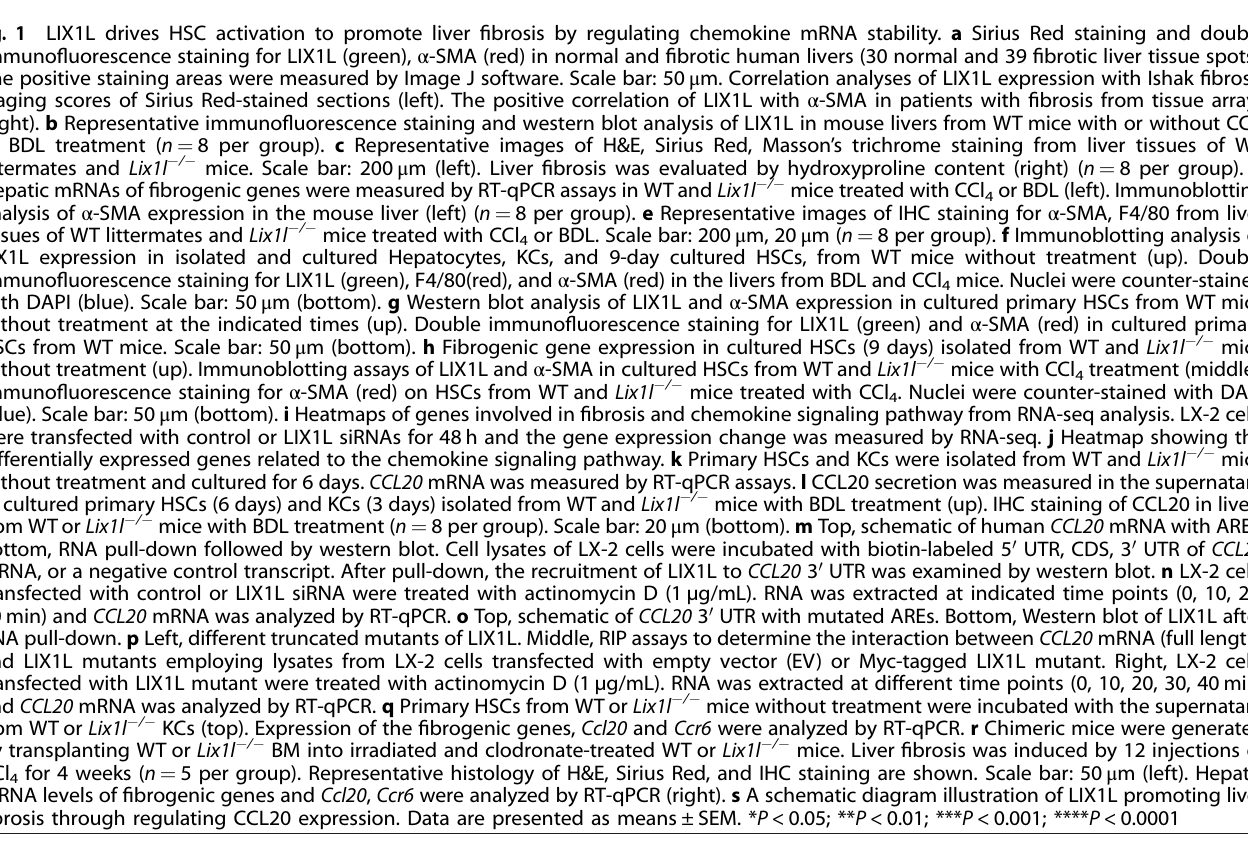
Fig. 1 LIX1L drives HSC activation to promote liver fi brosis by regulating chemokine mRNA stability. a Sirius Red staining and double immuno fl uorescence staining for LIX1L (green), α -SMA (red) in normal and fi brotic human livers (30 normal and 39 fi brotic liver tissue spots). The positive staining areas were measured by Image J software. Scale bar: 50 μ m. Correlation analyses of LIX1L expression with Ishak fi brosis staging scores of Sirius Red-stained sections (left). The positive correlation of LIX1L with α -SMA in patients with fi brosis from tissue arrays (right). b Representative immuno fl uorescence staining and western blot analysis of LIX1L in mouse livers from WT mice with or without CCl 4 or BDL treatment ( n = 8 per group). c Representative images of H&E, Sirius Red, Masson ’ s trichrome staining from liver tissues of WT littermates and Lix1l − / − mice. Scale bar: 200 μ m (left). Liver fi brosis was evaluated by hydroxyproline content (right) ( n = 8 per group). d Hepatic mRNAs of fi brogenic genes were measured by RT-qPCR assays in WT and Lix1l − / − mice treated with CCl 4 or BDL (left). Immunoblotting analysis of α -SMA expression in the mouse liver (left) ( n = 8 per group). e Representative images of IHC staining for α -SMA, F4/80 from liver tissues of WT littermates and Lix1l − / − mice treated with CCl 4 or BDL. Scale bar: 200 μ m, 20 μ m ( n = 8 per group). f Immunoblotting analysis of LIX1L expression in isolated and cultured Hepatocytes, KCs, and 9-day cultured HSCs, from WT mice without treatment (up). Double immuno fl uorescence staining for LIX1L (green), F4/80(red), and α -SMA (red) in the livers from BDL and CCl 4 mice. Nuclei were counter-stained with DAPI (blue). Scale bar: 50 μ m (bottom). g Western blot analysis of LIX1L and α -SMA expression in cultured primary HSCs from WT mice without treatment at the indicated times (up). Double immuno fl uorescence staining for LIX1L (green) and α -SMA (red) in cultured primary HSCs from WT mice. Scale bar: 50 μ m (bottom). h Fibrogenic gene expression in cultured HSCs (9 days) isolated from WT and Lix1l − / − mice without treatment (up). Immunoblotting assays of LIX1L and α -SMA in cultured HSCs from WT and Lix1l − / − mice with CCl 4 treatment (middle). Immuno fl uorescence staining for α -SMA (red) on HSCs from WT and Lix1l − / − mice treated with CCl 4 . Nuclei were counter-stained with DAPI (blue). Scale bar: 50 μ m (bottom). i Heatmaps of genes involved in fi brosis and chemokine signaling pathway from RNA-seq analysis. LX-2 cells were transfected with control or LIX1L siRNAs for 48 h and the gene expression change was measured by RNA-seq. j Heatmap showing the differentially expressed genes related to the chemokine signaling pathway. k Primary HSCs and KCs were isolated from WT and Lix1l − / − mice without treatment and cultured for 6 days. CCL20 mRNA was measured by RT-qPCR assays. l CCL20 secretion was measured in the supernatant of cultured primary HSCs (6 days) and KCs (3 days) isolated from WT and Lix1l − / − mice with BDL treatment (up). IHC staining of CCL20 in livers from WTor Lix1l − / − mice with BDL treatment ( n = 8 per group). Scale bar: 20 μ m (bottom). m Top, schematic of human CCL20 mRNA with AREs. Bottom, RNA pull-down followed by western blot. Cell lysates of LX-2 cells were incubated with biotin-labeled 5 ′ UTR, CDS, 3 ′ UTR of CCL20 mRNA, or a negative control transcript. After pull-down, the recruitment of LIX1L to CCL20 3 ′ UTR was examined by western blot. n LX-2 cells transfected with control or LIX1L siRNA were treated with actinomycin D (1 µg/mL). RNA was extracted at indicated time points (0, 10, 20, 30 min) and CCL20 mRNA was analyzed by RT-qPCR. o Top, schematic of CCL20 3 ′ UTR with mutated AREs. Bottom, Western blot of LIX1L after RNA pull-down. p Left, different truncated mutants of LIX1L. Middle, RIP assays to determine the interaction between CCL20 mRNA (full length) and LIX1L mutants employing lysates from LX-2 cells transfected with empty vector (EV) or Myc-tagged LIX1L mutant. Right, LX-2 cells transfected with LIX1L mutant were treated with actinomycin D (1 µg/mL). RNA was extracted at different time points (0, 10, 20, 30, 40 min) and CCL20 mRNA was analyzed by RT-qPCR. q Primary HSCs from WT or Lix1l − / − mice without treatment were incubated with the supernatant from WT or Lix1l − / − KCs (top). Expression of the fi brogenic genes, Ccl20 and Ccr6 were analyzed by RT-qPCR. r Chimeric mice were generated by transplanting WT or Lix1l − / − BM into irradiated and clodronate-treated WT or Lix1l − / − mice. Liver fi brosis was induced by 12 injections of CCl 4 for 4 weeks ( n = 5 per group). Representative histology of H&E, Sirius Red, and IHC staining are shown. Scale bar: 50 μ m (left). Hepatic mRNA levels of fi brogenic genes and Ccl20 , Ccr6 were analyzed by RT-qPCR (right). s A schematic diagram illustration of LIX1L promoting liver fi brosis through regulating CCL20 expression. Data are presented as means ± SEM. * P < 0.05; ** P < 0.01; *** P < 0.001; **** P <